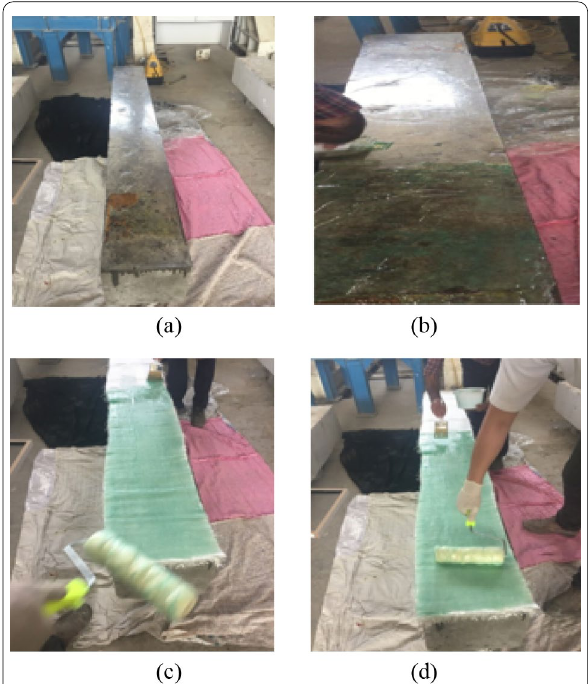
Fig. 5 Resining of 3D-fiberglass: a cleaning the surface, b distributing 40% of the total quantity of resin, c placing 3D-fiberglass on a concrete surface, and d impregnating layers and surface.